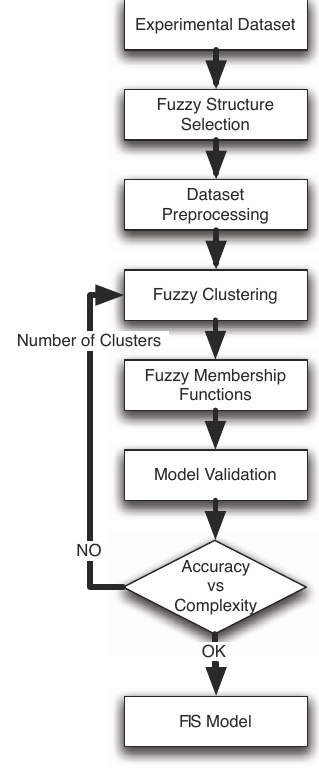
Figure 1. Modeling